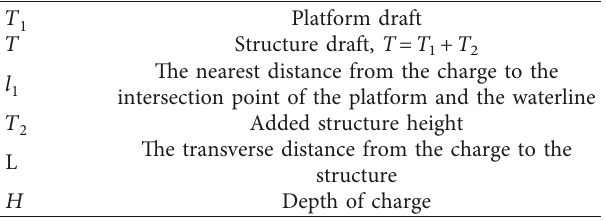
Figure 7: The condition at S